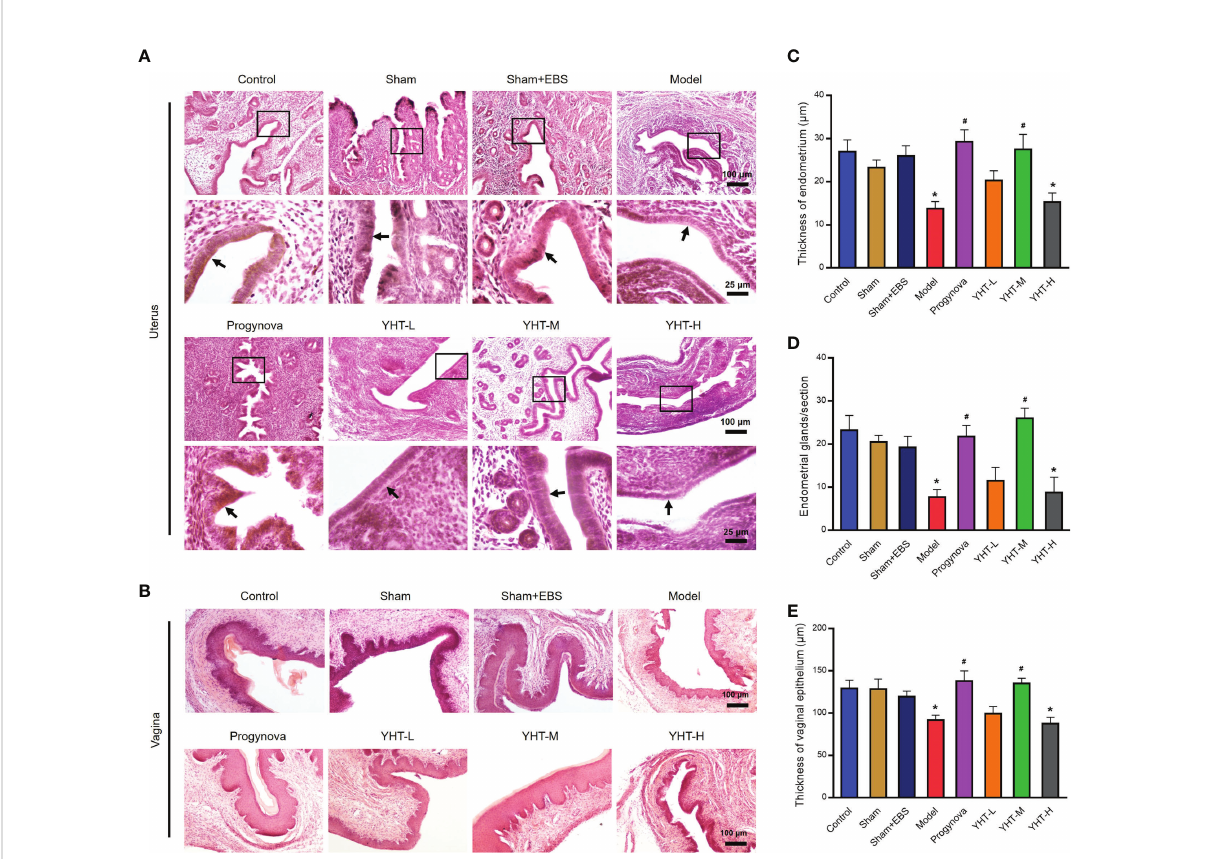
FIGURE 3 Histological effects of YHT on the uterus and vagina in menopausal mice. (A) Uterus. (B) Vagina. (C) Thickness of endometrium. (D) Number of endometrial glands. (E) Thickness of vaginal epithelium. *p < 0.05 vs control group; #p < 0.05 vs model group. EBS, empty bottle